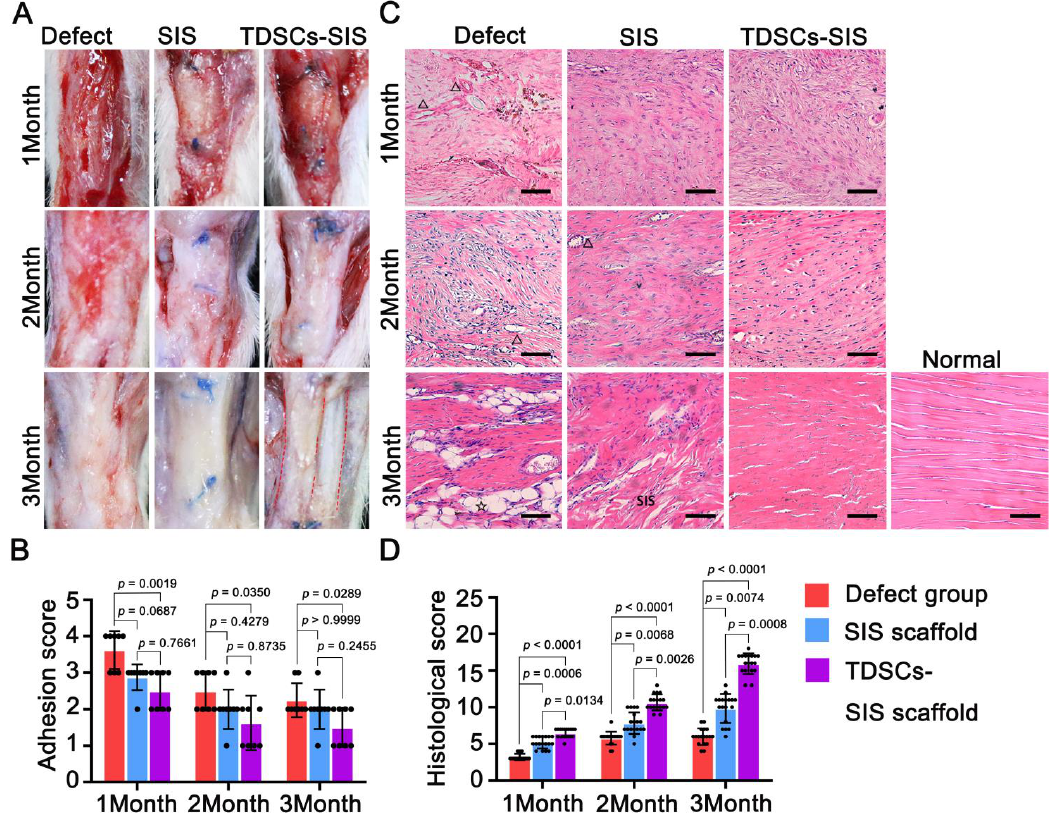
Figure 4. TDSCs – SIS scaffold (TDSCs – SIS) could have antiadhesion and promote histological healing. ( A ) At the third month, the SIS scaffold in the TDSCs – SIS group was degraded earlier than all groups, exposing 2 strands of Achilles tendon tissue, and no peritendinous adhesions occurred by macrographic evaluation, n = 8. ( B ) The adhesion score through macrographic evaluation, n = 8. ( C ) Histological sections were stained with hematoxylin and eosin in the Achilles tendon defects of the blank defect or implantation with scaffold (SIS and TDSCs – SIS) after 1, 2, and 3 months, n = 4. Bar: 75μm. △ represents vessel. ☆ represents adipocyte. ( D ) The histological score; 20 points is a normal Achilles tendon, n = 4. Data in ( B ) ( n = 8) and ( D ) ( n = 4) are mean ± S.D. analyzed by one-way analysis of variance (ANOVA) with Bonferroni post hoc multiple comparisons.